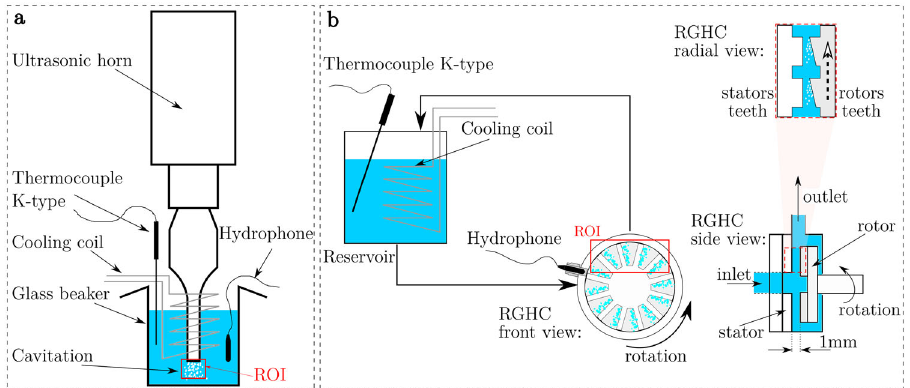
Fig. 8 Experimental set-up schemes for a AC and b HC. Red rectangular frame presents region of interest (ROI) captured by high-speed visualization. Positions of hydrophone, thermometer and cooling coil are schematically drawn. npj Clean Water (2023)